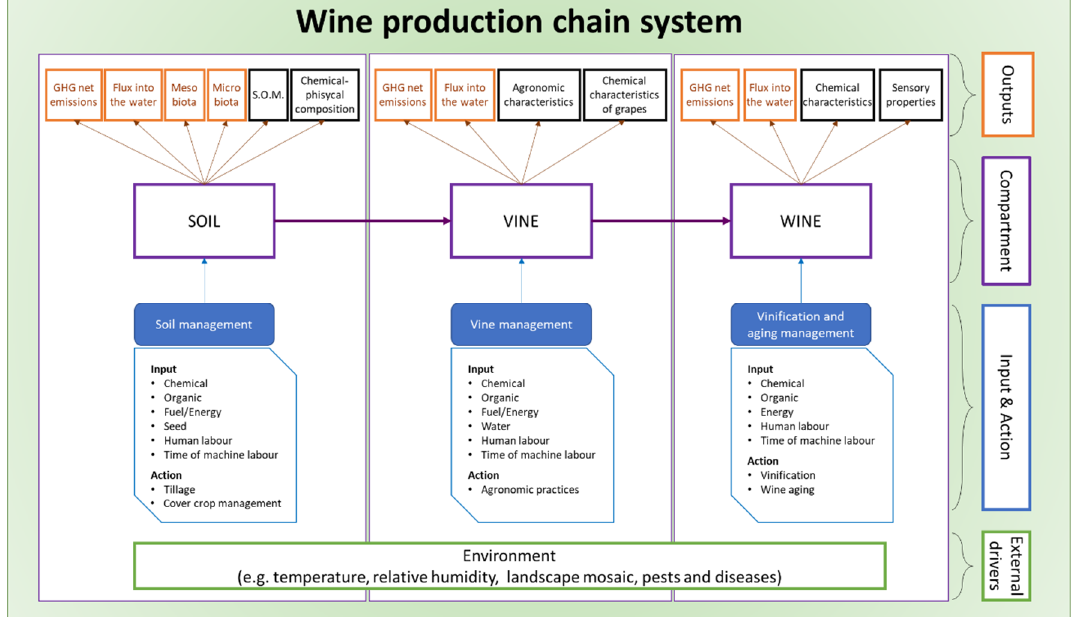
Figure 1. Diagram of the wine production chain. Input and actions (blue boxes), and production output (black boxes) are shown for each component, in addition to chemical and biological output (orange boxes).